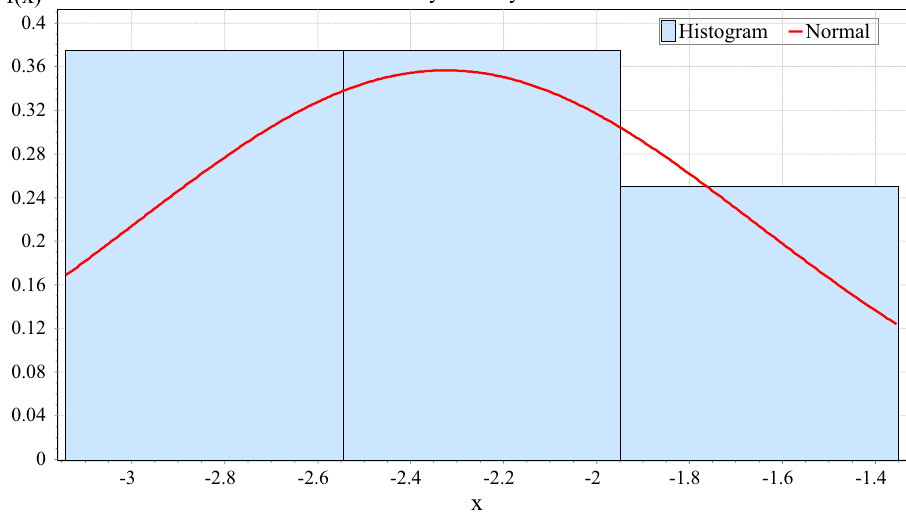
Fig. 2 Histogram of the loga- rithm of the solubilities from Table 2